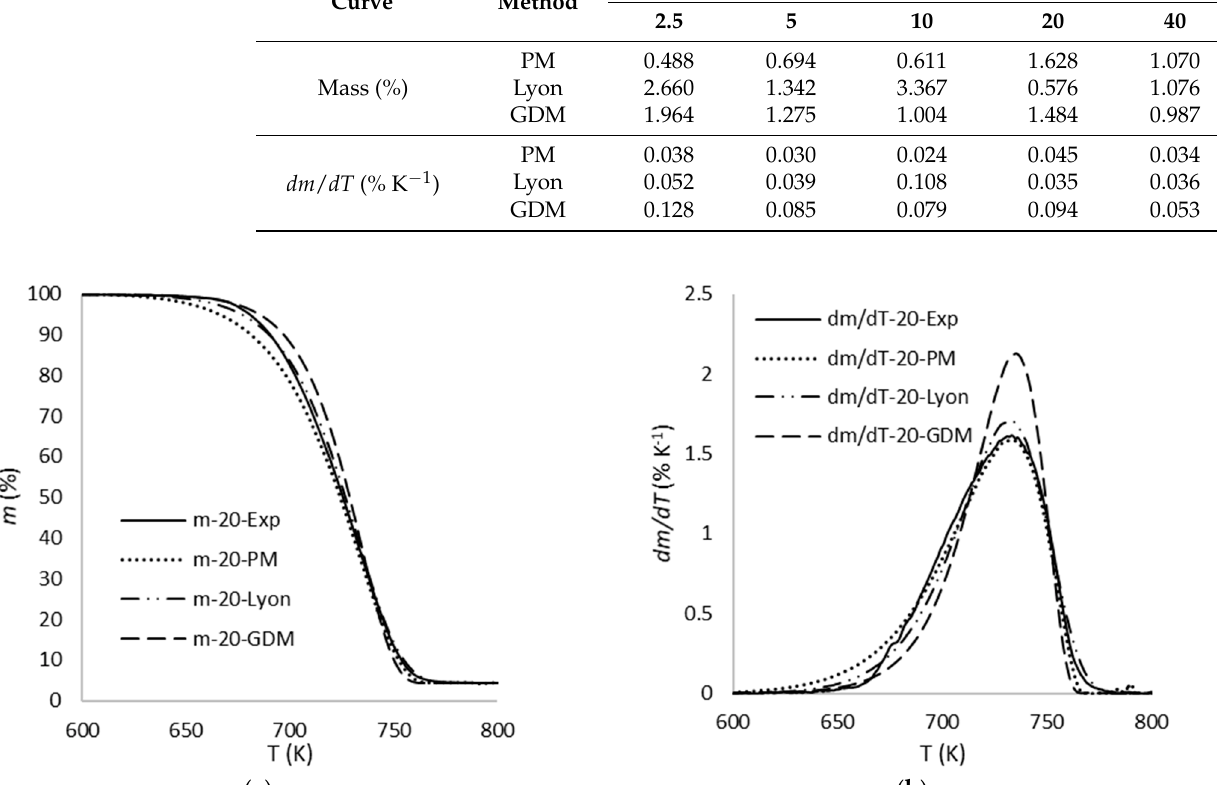
Figure 8. A comparison of experimental and calculated ( a ) mass and ( b ) dm / dT results for PA 6.6 at a heating rate of 20 K min − 1 .